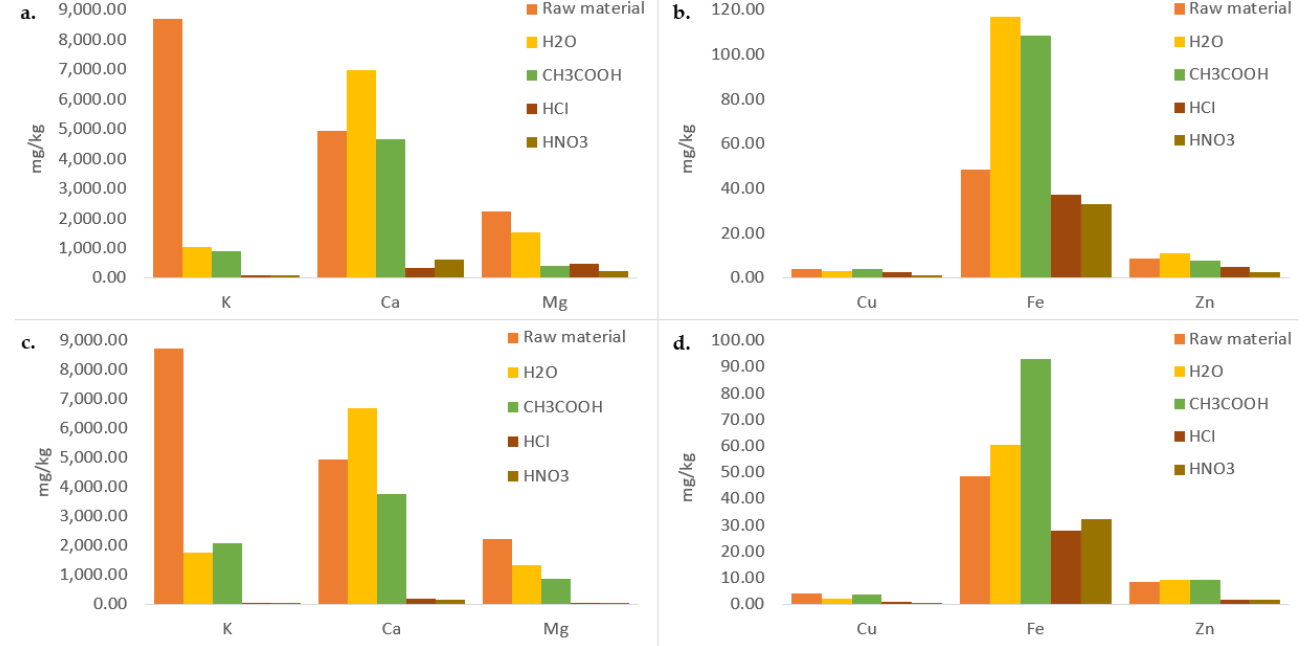
Figure 2. Atomic spectrometry analysis of: ( a ) macro elements in untreated and treated corn II within 30 min ( b ) micro elements in untreated and treated corn II within 30 min ( c ) macro elements in untreated and treated corn II within 240 min ( d ) micro elements in untreated and treated corn II within 240 min.